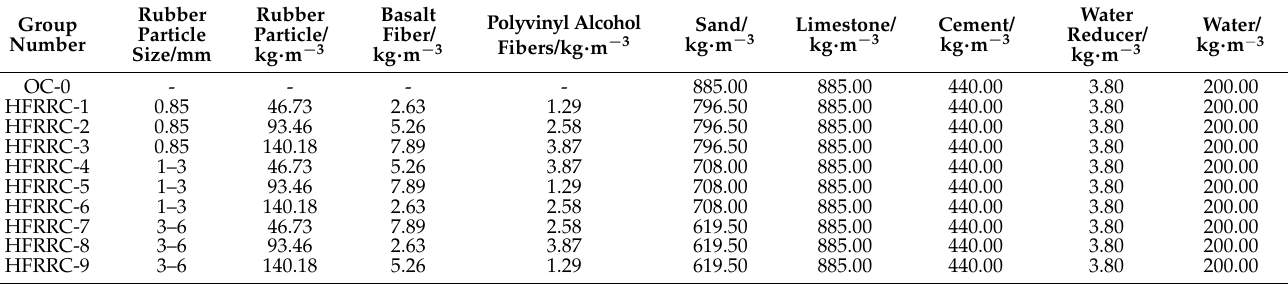
Table 7. Mixing proportions of the